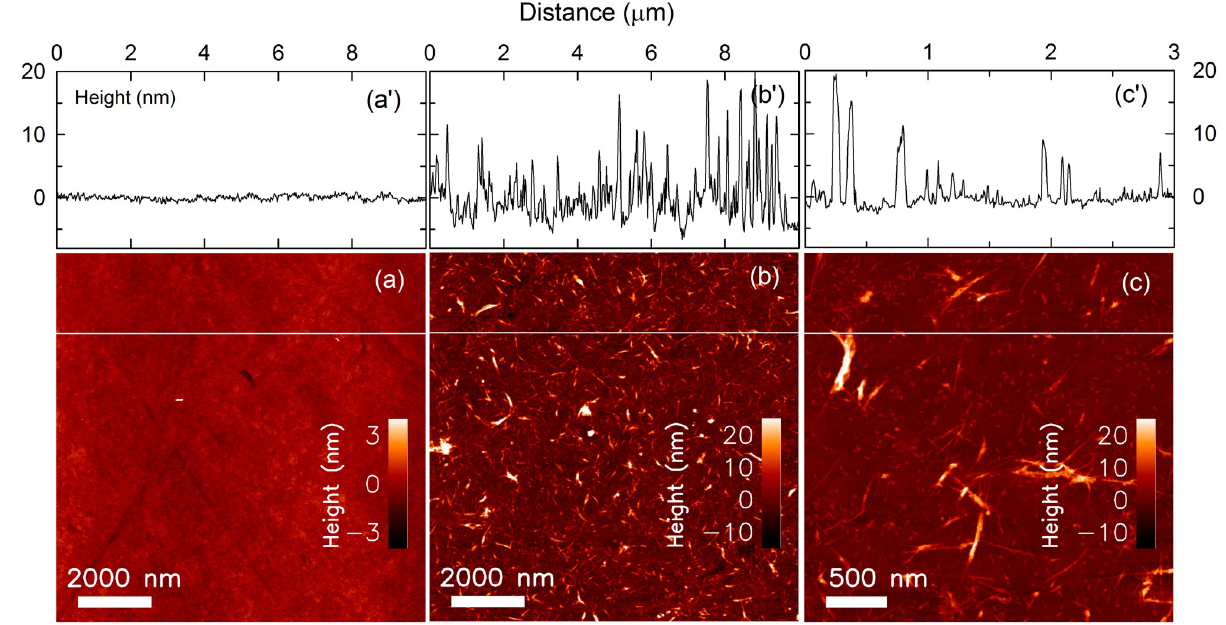
Fig 1. AFM topographs with cross sections of the uncoated glass and the SWNT coated glass. AFM height topographs of (a) the uncoated glass, (b) the SWNT densely coated glass and (c) the SWNT thin coated glass, and a’, b’ and c’ are the height information of cross-section view along the white lines shown on the topographs a, b and c,